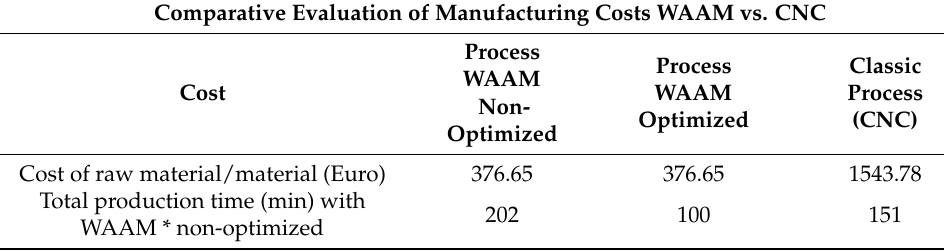
Table 8. Comparison of costs for piece/component of